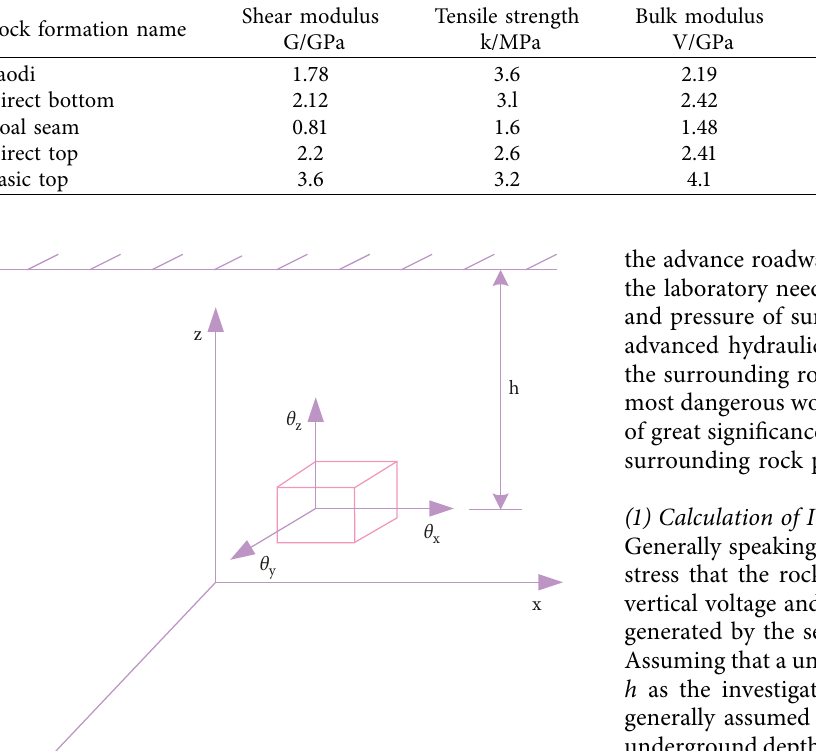
Table 1: Physical and mechanical parameters of roof and floor.